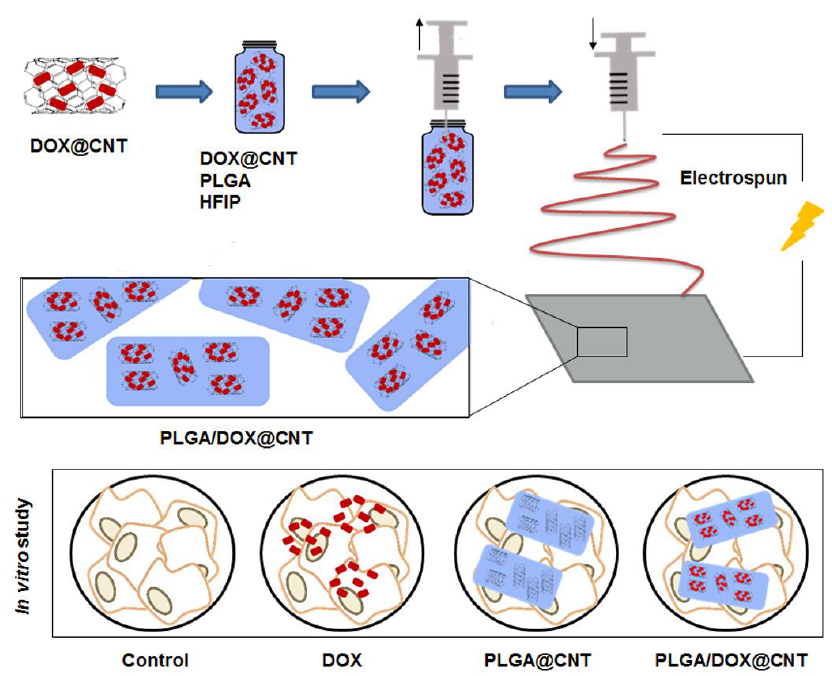
Figure 5. Schematic illustration for the fabrication process of PLGA/DOX-IN-CNTs electrospun composite NFs. The morphology and diameter distributions of PLGA and PLGA/DOX@CNTs composite NFs [74].